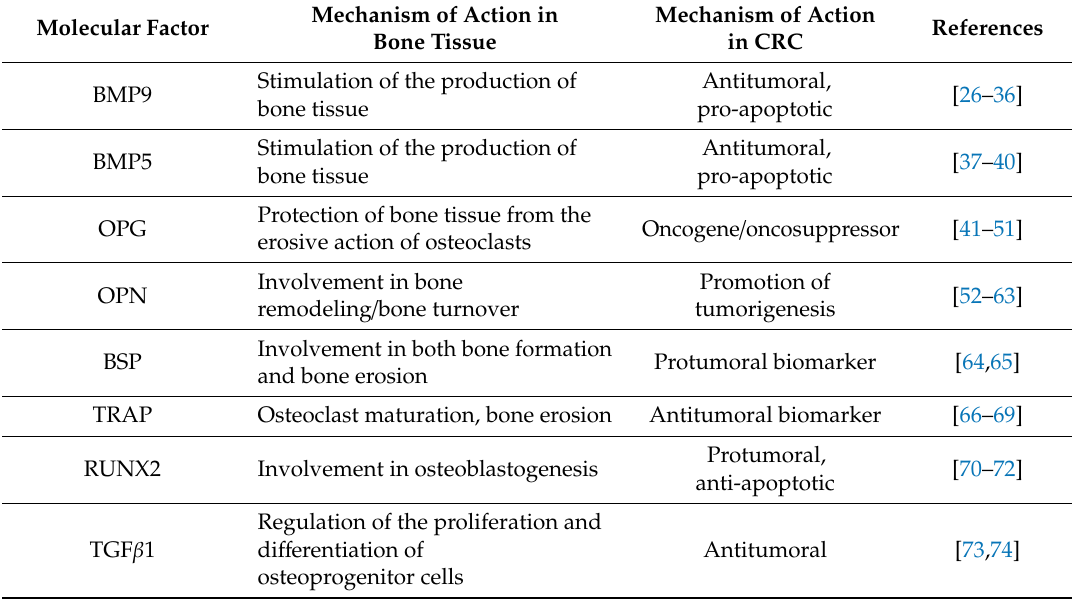
Table 1. Molecular factors and their mechanisms of action in bone tissue and in Colorectal Cancer (CRC). Molecular